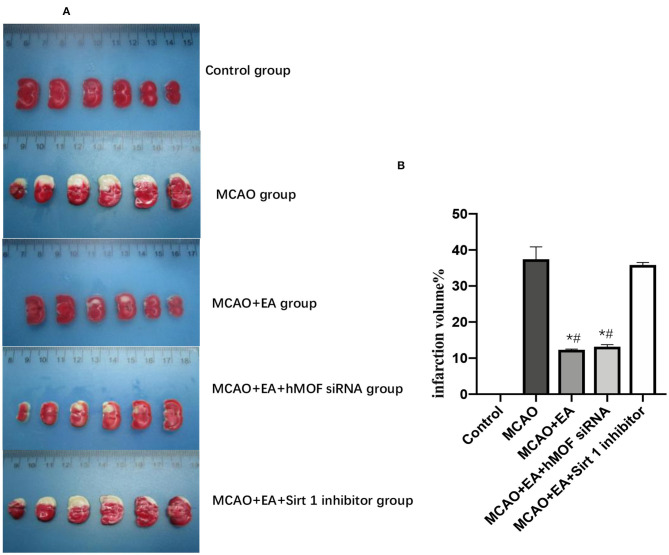
Image showing changes of infarct volume. (A) Typical photo micrographs of ischemic penumbra identified with TTC staining. (B) Calculation results of infarct volume; n = 6 per group. *P < 0.05, vs. the MCAO group; #P < 0.05, vs. the MCAO+EA+Sirt1 inhibitor group.